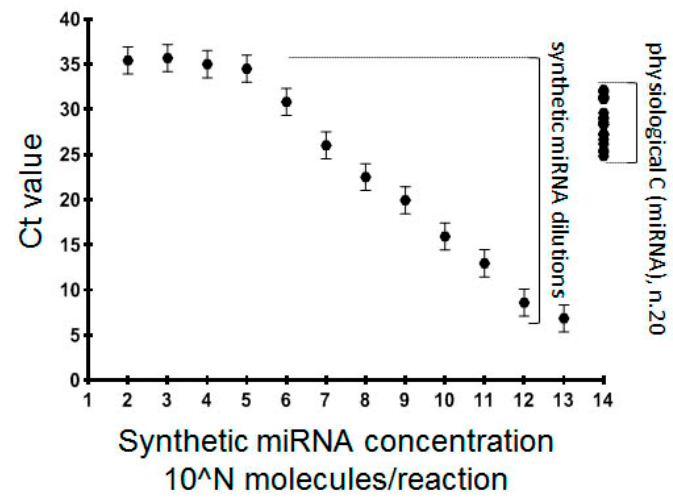
Figure 3. Analytic properties of the tt-RT-PCR system for miRNA-10b. The system (tt-RT-PCR) for miR-10b analysis was designed and tested with a row of synthetic mimic dilutions from 10 2 to 10 13 molecules per RT reaction. A linear dependency between the miR-10b concentration and the Ct value was observed in a range 10 5 to 10 12 . The physiological concentration of miR-10b in a collection of 20 RNA samples was tested additionally.